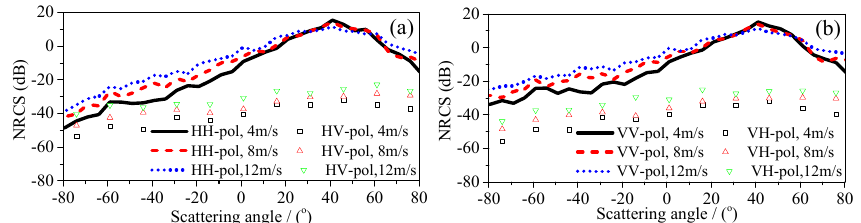
Figure 12. Variation of Bistatic NRCS with wind speeds evaluated by FPFSM for different polarization states. ( a ) HH and HV polarizations. ( b ) VV and VH polarizations.